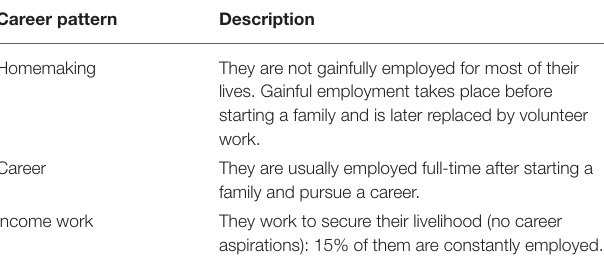
TABLE 6 | Career patterns of women according to Holahan and Sears (1995). Career